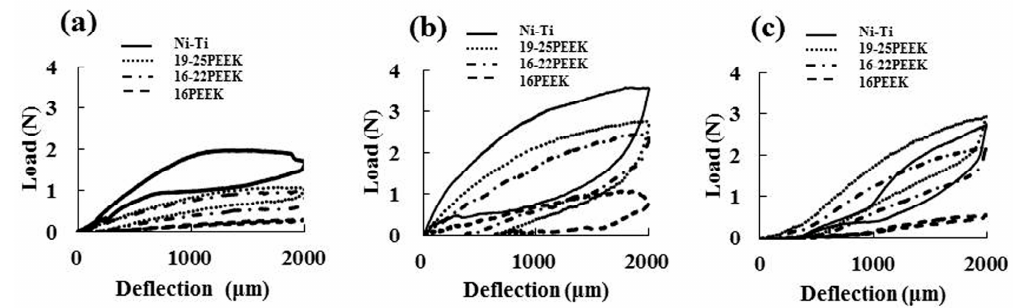
Figure 1. Load-deflection curves by three-point bending test ( a ) no-ligation; ( b ) elastomeric ligature; ( c ) slot